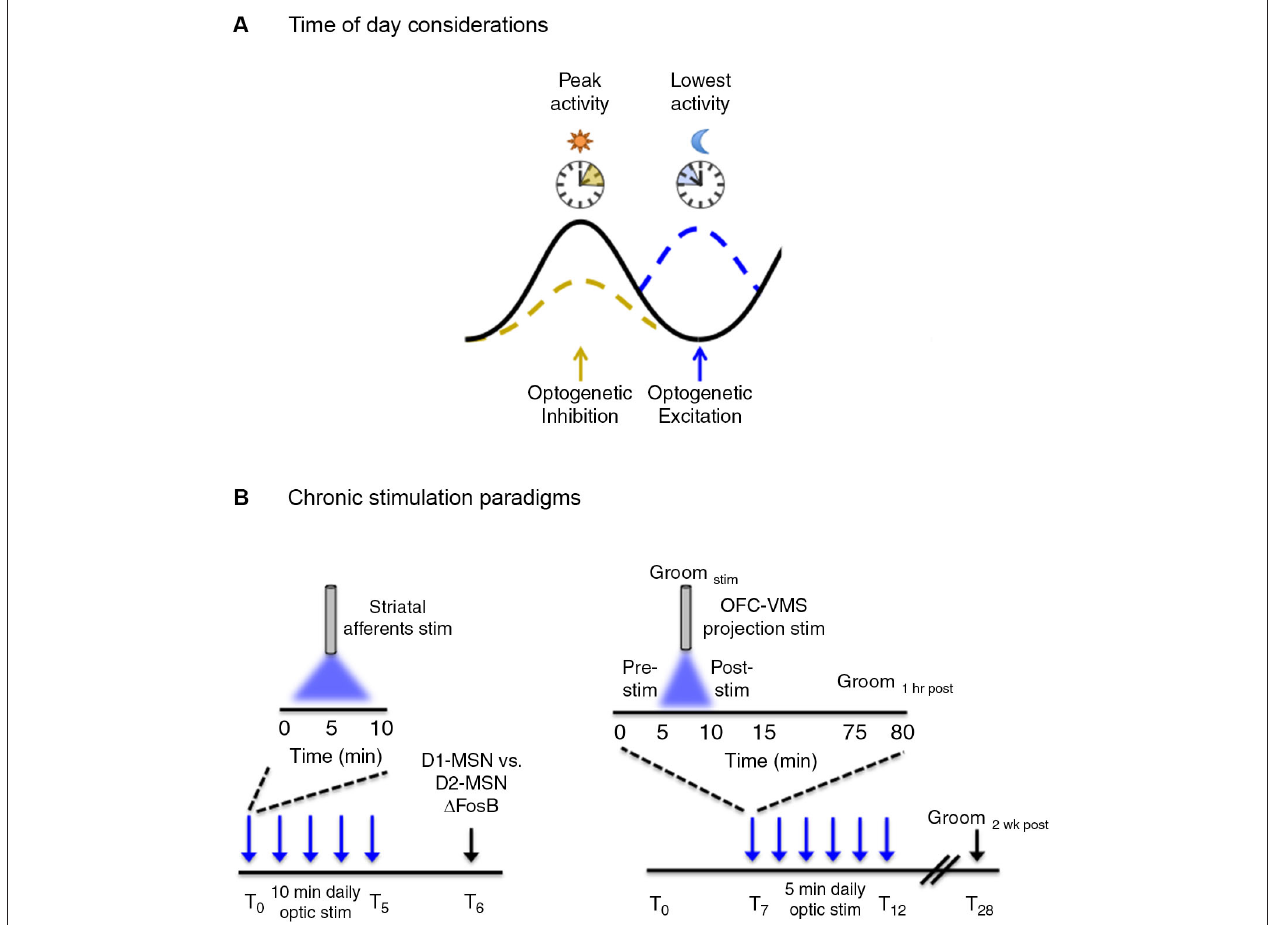
FIGURE 2 | Temporal considerations for optogenetic manipulation of neural activity. (A) Neural activity exhibits natural daily rhythms with distinct peaks and troughs of activity emerging throughout the 24 h light/dark cycle. Neural circuit manipulation during these peaks and troughs may yield more pronounced behavioral effects, i.e., inhibition of a given circuit when activity is usually highest may be preferred over inhibiting when activity is at a daily low. This is a generalized concept and the converse may be equally as valid depending on the type of experiment performed and the purpose of optogenetic manipulation. (B, left) (cid:49) FosB induction, a marker of chronic neural activity, was measured in striatal dopamine rececptor-1 (D1) and dopamine receptor 2 (D2) medium spiny neurons (MSNs) following five consecutive days of optogenetic stimulation of ChR2-expressing neurons in the following striatal afferents: medial prefrontal cortex (mPFC), amygdala, ventral hippocampus and the VTA. Daily optic stimulations involved 10 min bouts of blue light